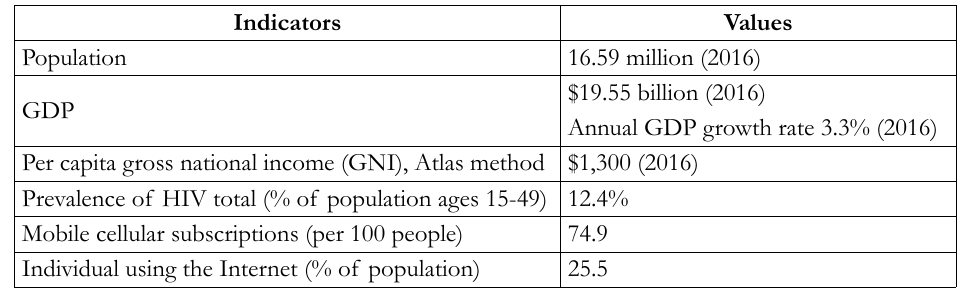
Table 1. Zambia Indicators (World Bank,